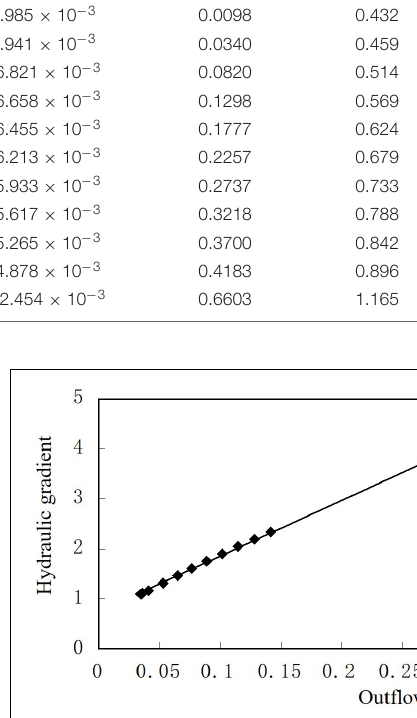
conduit diameter under the condition of the fixed fissure aperture value and initial hydraulic pressure value because of the increasing cross section of the conduit in the